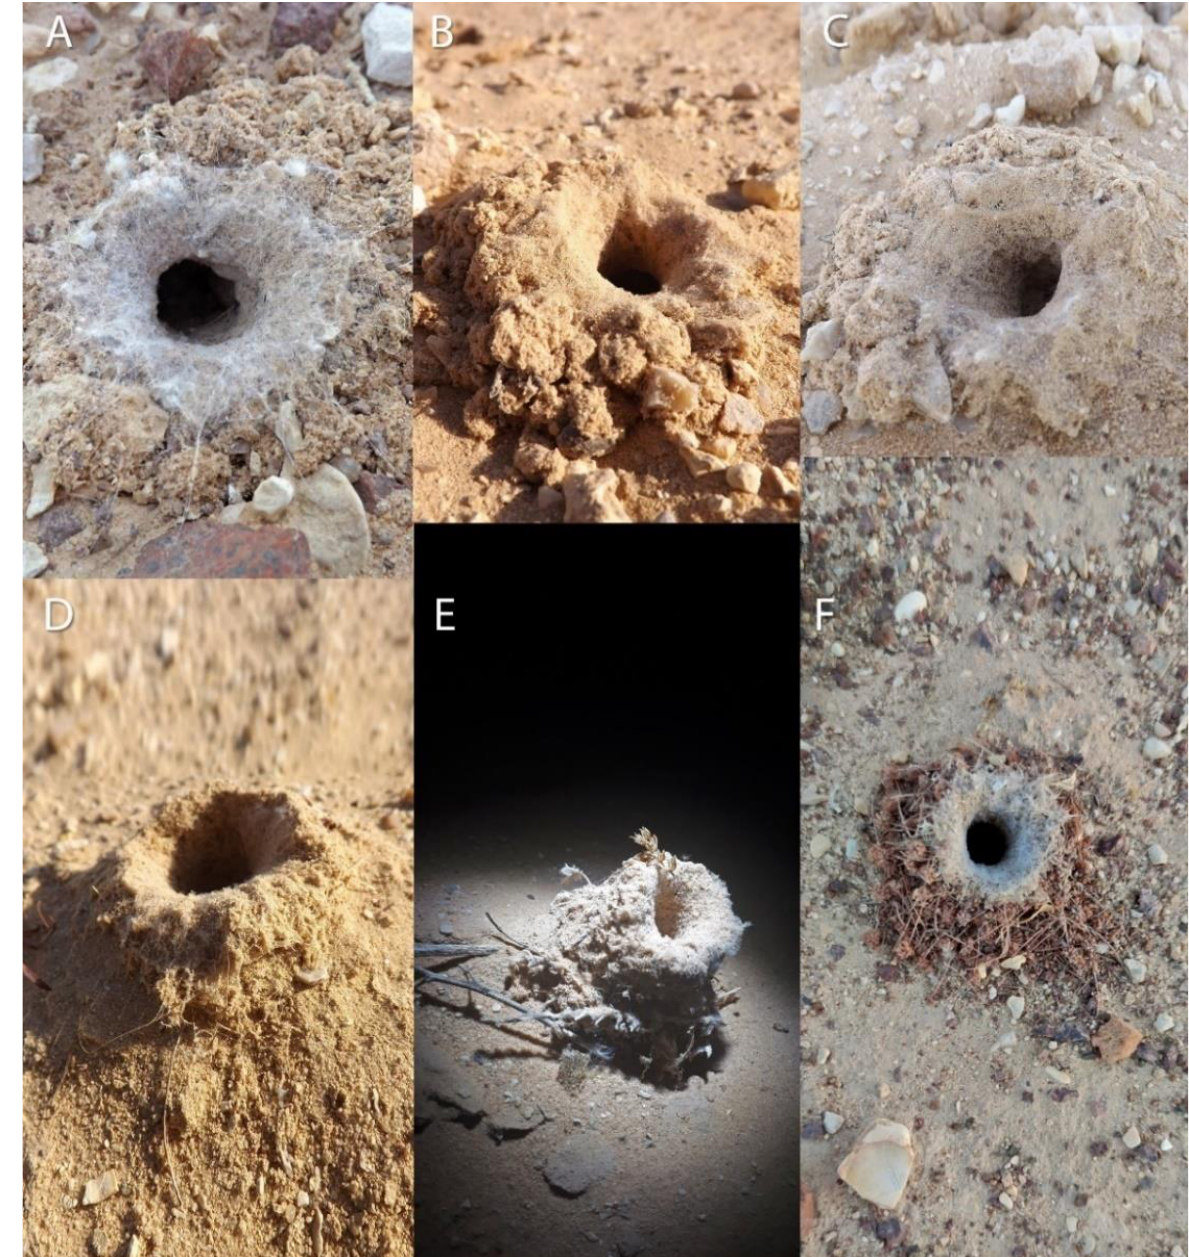
Figure 3. Sahastata burrows. ( A , C , F ): ‘Avrona nature reserve 1975 area dominated by loess covered by stones (gravel), ( B , D ): ‘Avrona nature reserve 2014 area dominated by sand and loess soils, ( E ): Yotvata sand dune. Pictures: ( A – D ): Igor Armiach Steinpress, ( E ): Nitzan Segev, ( F ): Yoram Zvik.